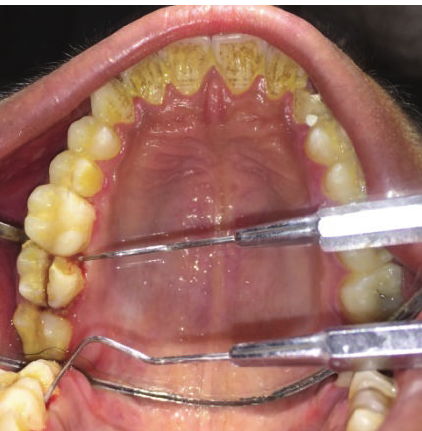
Figure 5: Preoperative radiograph of 37.